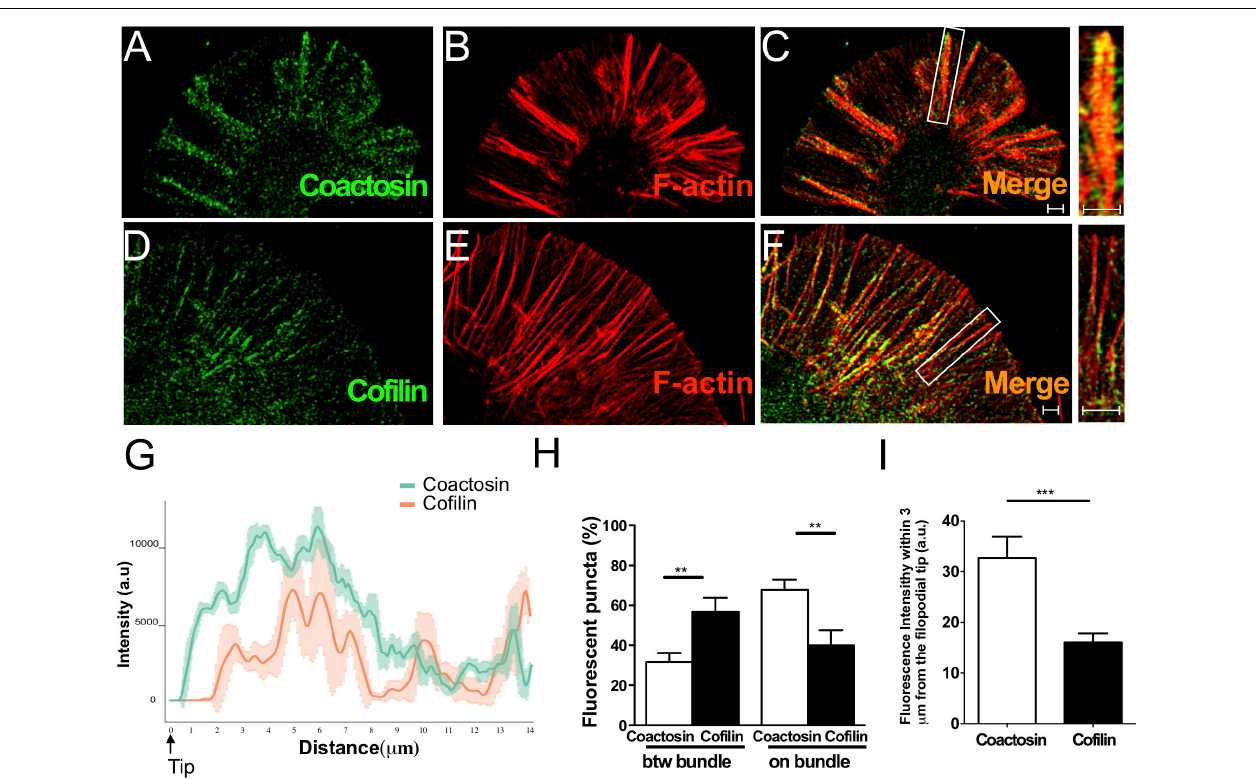
FIGURE 3 | Distribution of coactosin and cofilin in the growth cones of NG108-15 cells. (A–C) SIM images showing the co-localization of endogenous coactosin ( green ) and F-actin (rhodamine-phalloidin, red ) in a growth cone. (D–F) Co-localization of cofilin ( green ) and F-actin ( red ) in a growth cone. Note that cofilin accumulation on F-actin is weak at the tip of filopodia (inset). (G) Quantitative distribution of the fluorescence intensities of coactosin ( green ) and cofilin ( red ). Measurements were performed 14 µ m from a filopodial tip ( n = 18 for each, means ± SEM). (H) Quantitative analysis of the association of coactosin or cofilin with F-actin. Approximately 68% of the coactosin-positive pixels were located on actin bundles (“on bundle”), while the rest were located between actin bundles (“btw bundle”). The data are shown as means ± SEM (19–26 bundles, ** p < 0.01, Mann–Whitney U -test). (I) Quantification of the percent association with F-actin within 3 µ m of the filopodial tip. The data are shown as means ± SEM (21–24 bundles, *** p = 0.0005, Mann–Whitney U -test). Scale bars, 1 µ